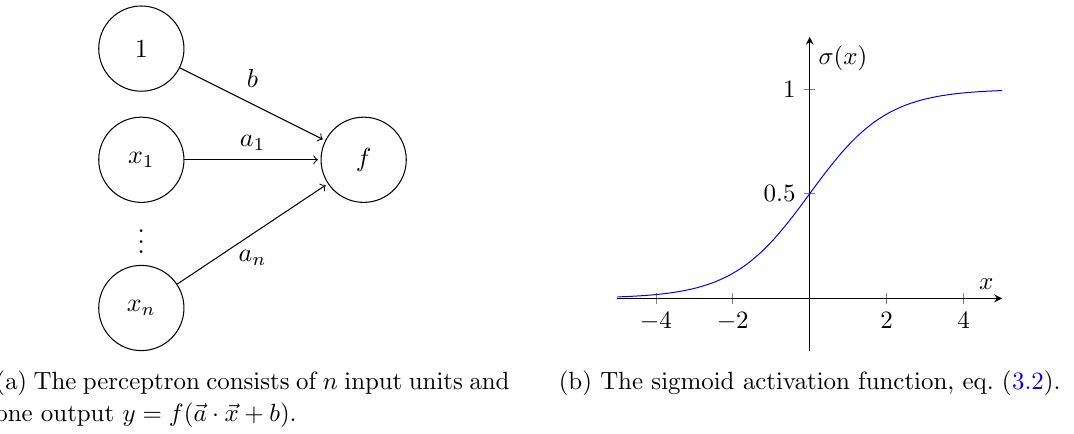
Figure 1 . Sketch of a perceptron (left) and of the sigmoid activation function